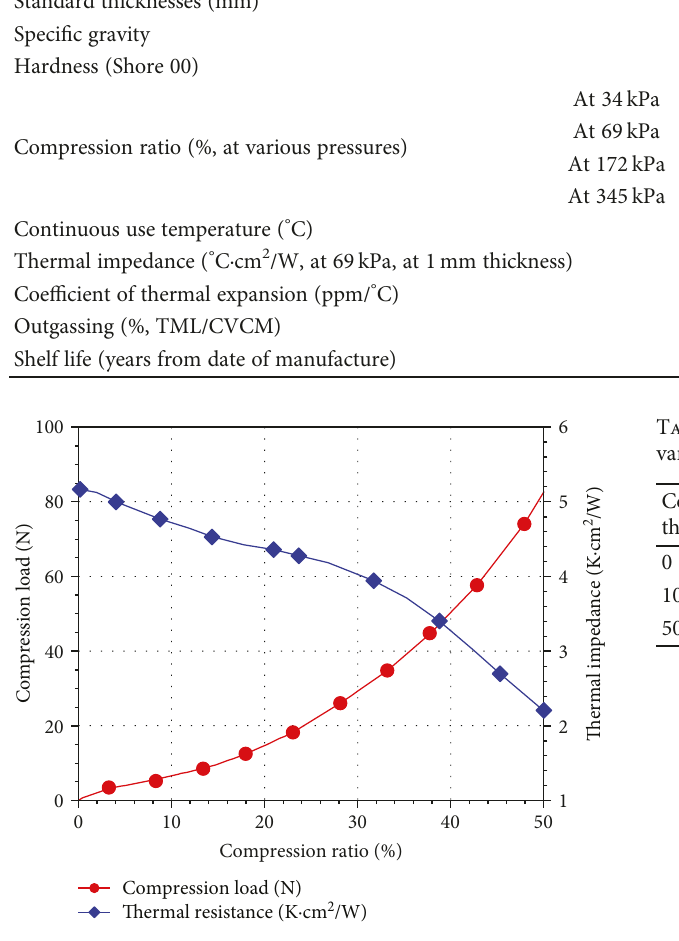
Figure 3: Compressive static load and thermal impedance for various compression ratios of the thermal gap pad.